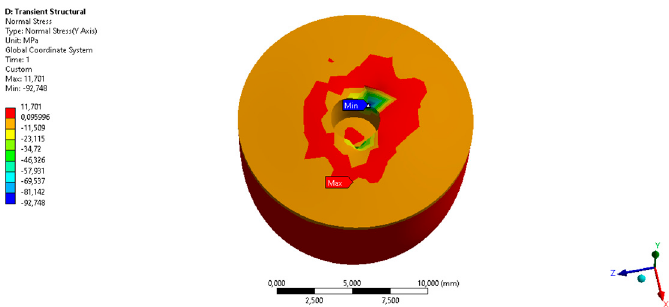
Figure 6. Thermal-Structural Analysis. Y-axis Normal Stress − 92.7 MPa.